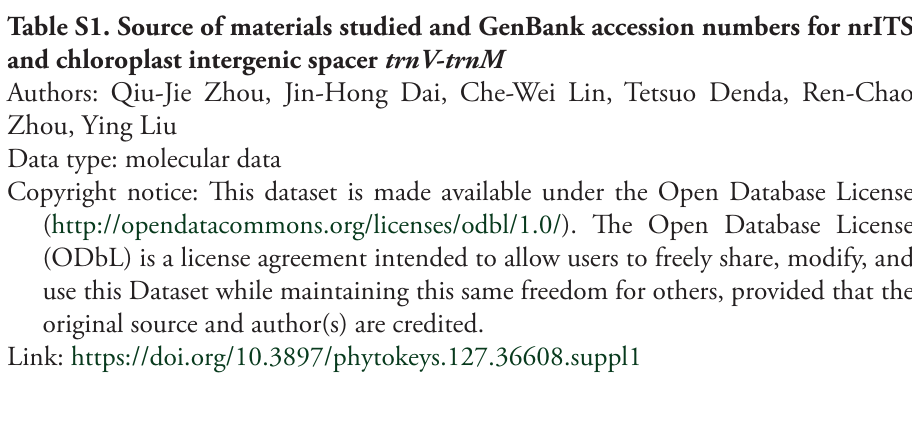
Table S1. Source of materials studied and GenBank accession numbers for nrITS and chloroplast intergenic spacer